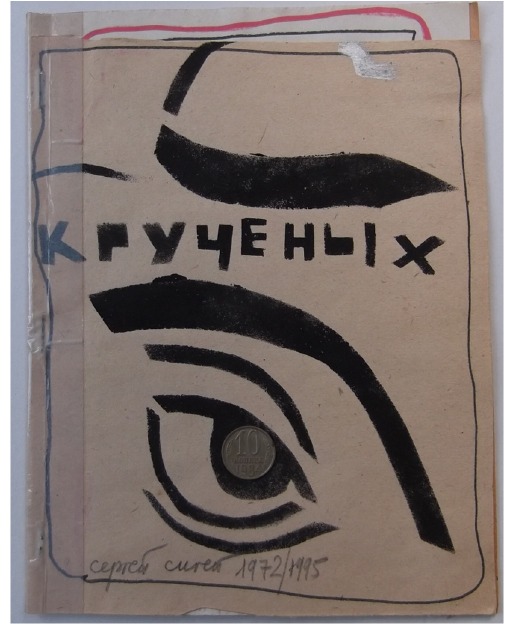
Figure 15. Second booklet of the box.